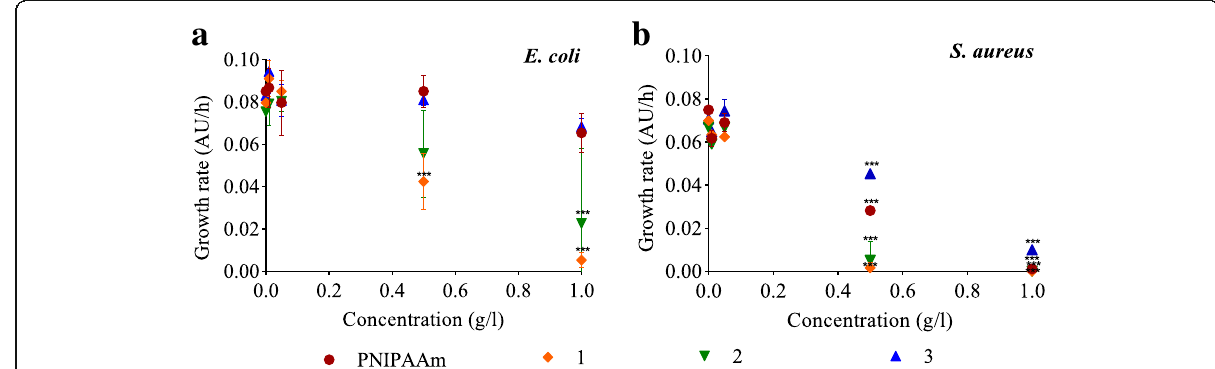
Fig. 5 Relative growth rate of Escherichia coli ( a ) and Staphylococcus aureus ( b ) after 6-h incubation in different concentrations (0.01, 0.05, 0.5 and 1 g/l) of PNIPAAm (red circles), Fe 3 O 4 -PNIPAAm-1 (orange diamonds [1]), Fe 3 O 4 -PNIPAAm-2 (green triangles [2]) and Fe 3 O 4 -PNIPAAm-3 (blue triangles [3]). The error bars show SD calculated from n = 3. Significance level *** P <